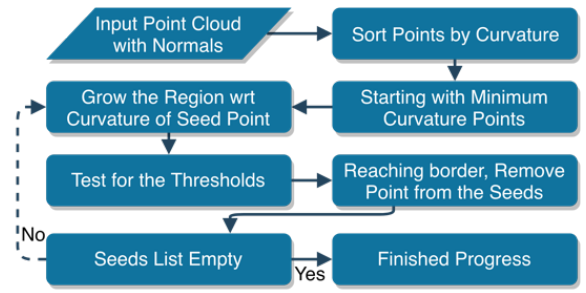
Figure 5. Region growing algorithm.